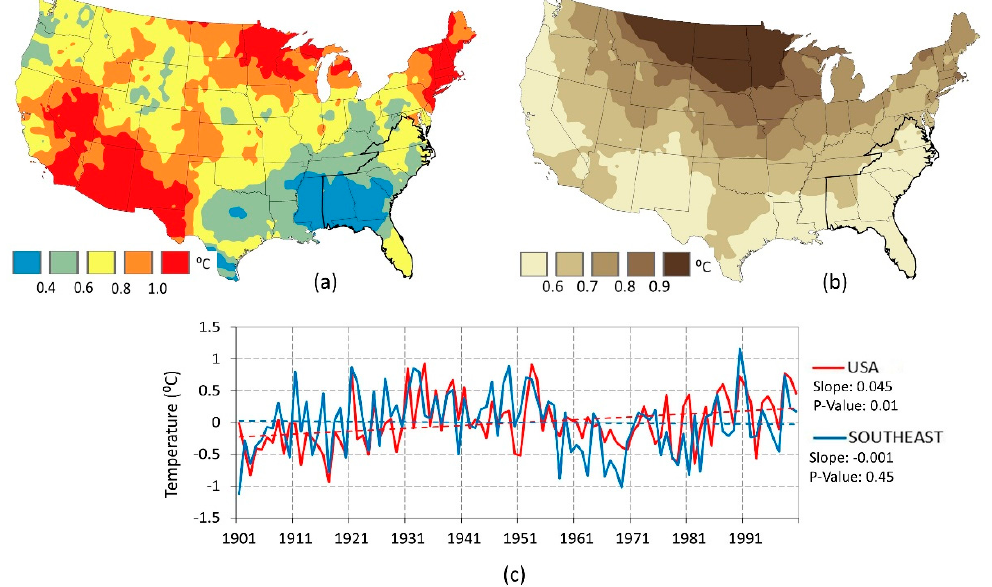
Figure 2. ( a ) Observed changes in annual temperature over the conterminous United States; changes are the difference between the average for present-day and the average for the last century (2001–2017 minus 1901–2000); ( b ) annual temperature variability (1901–2017) expressed as the standard deviation of anomalies. The thick black line delimits the study area; ( c ) 20th century temperature anomaly time series for the continental USA and the Southeast.